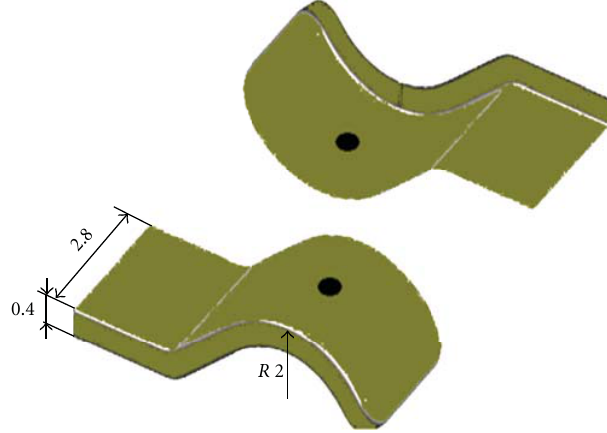
Figure 2: Contact springs.